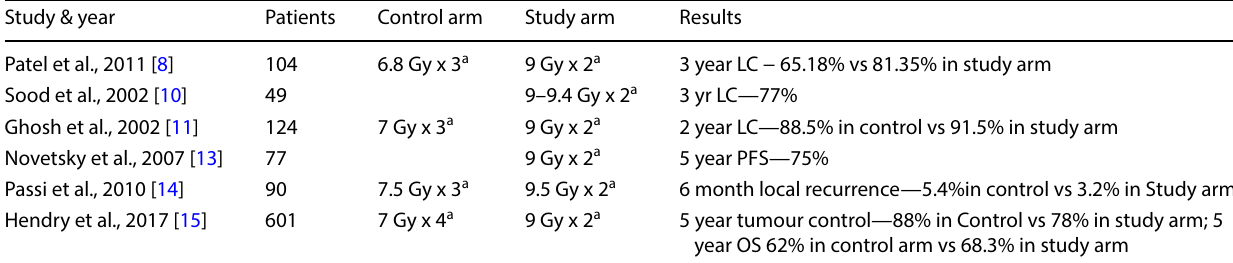
Table 3 Comparison of similar studies in literature